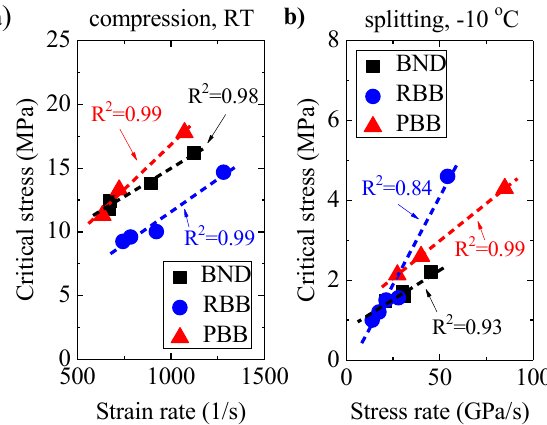
Figure 5. Critical stress dependencies on a strain rate under compression at room temperature ( a ) and splitting at a negative temperature ( b ) of bituminous binders. R 2 is the coefficients of determination.